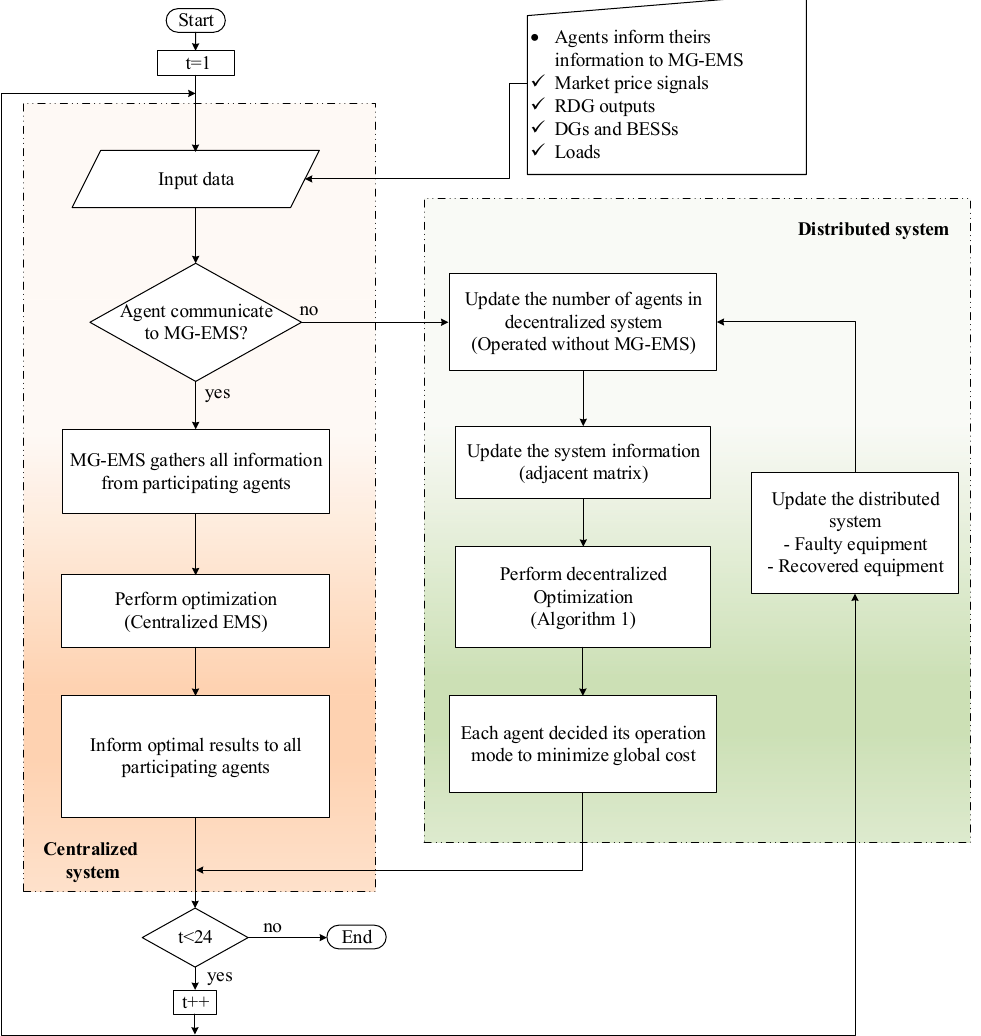
Figure 2. Flowchart for operation of the microgrid system.